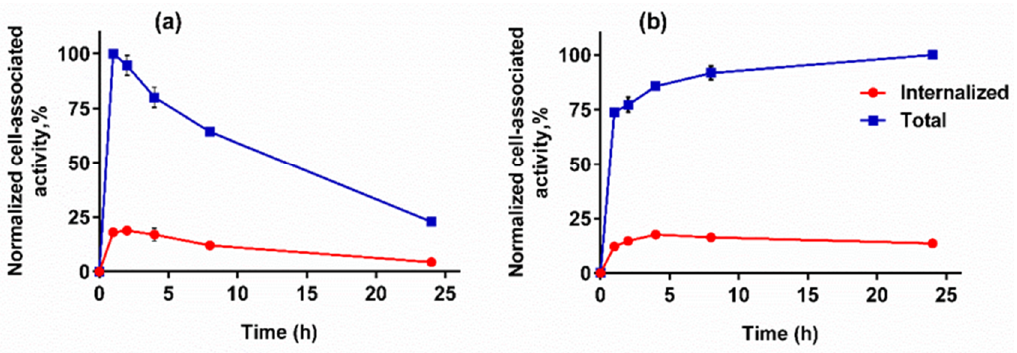
Figure 5. Cellular processing of ( a ) [ 125 I]I-Tyr-PEG 2 -RM26 and ( b ) [ 111 In]In-DOTA-PEG 2 -RM26 on PC-3. Data are presented as the mean values of three dishes ± SD. Not all error bars are visible due to the small standard deviations.